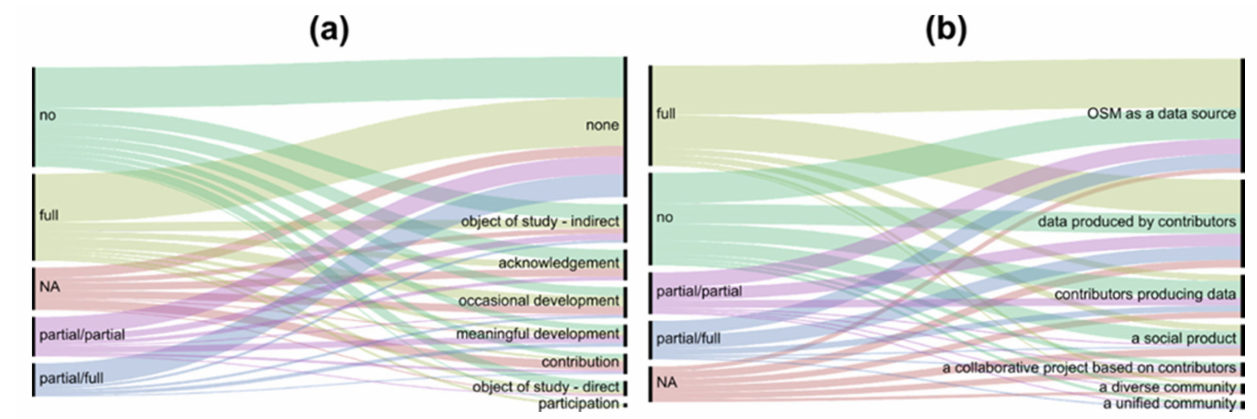
Figure 7. Alluvial diagrams connecting geographical correspondence with engagement ( a ) and perspective ( b